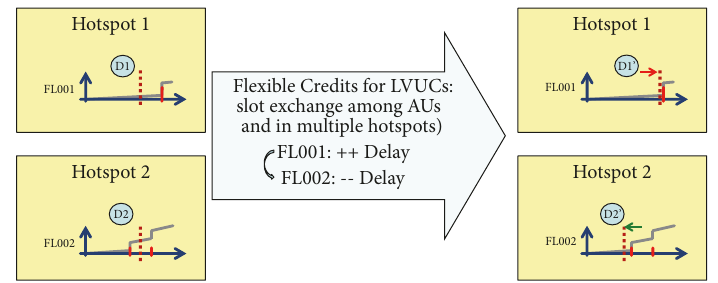
Figure 6: Illustration of an LVUC exchanging delay and credits between two hotspots.